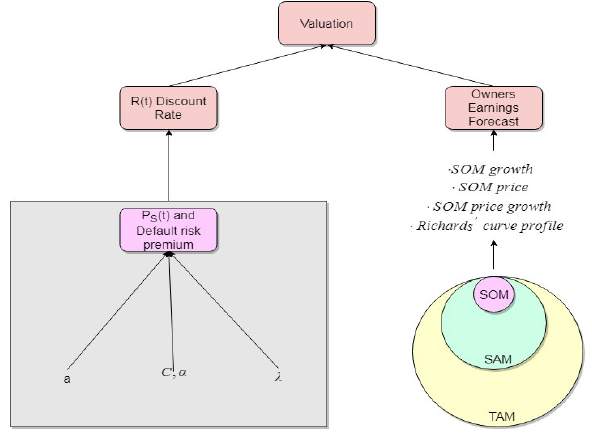
Figure 1: Map of valuation model